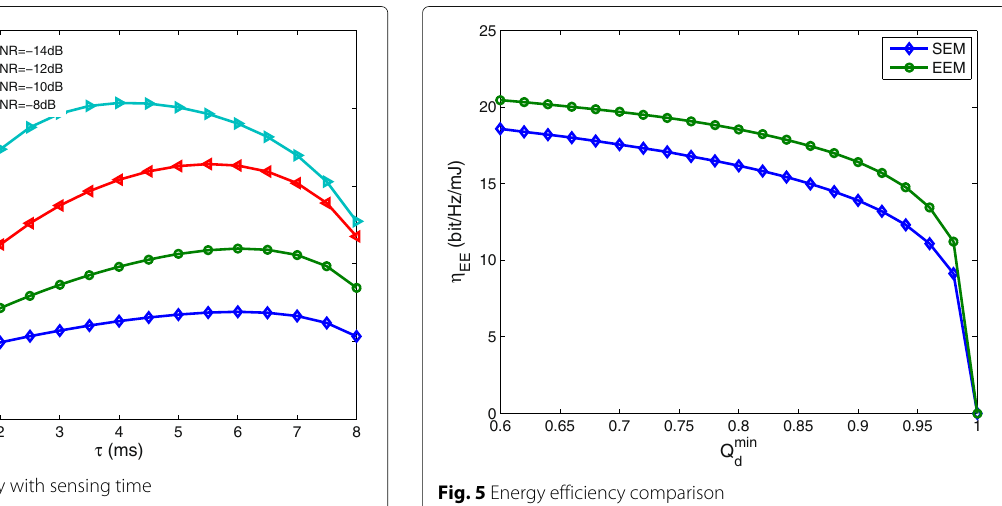
and sensing SNR increases. Figures 4 and 5 compare spec- trum efficiency and energy efficiency of SEM and EEM, respectively. We can see that SEM can obtain higher spec- trum efficiency while EEM may achieve higher energy = 10 mW, efficiency, due to the different optimization objectives of n SEM and EEM.